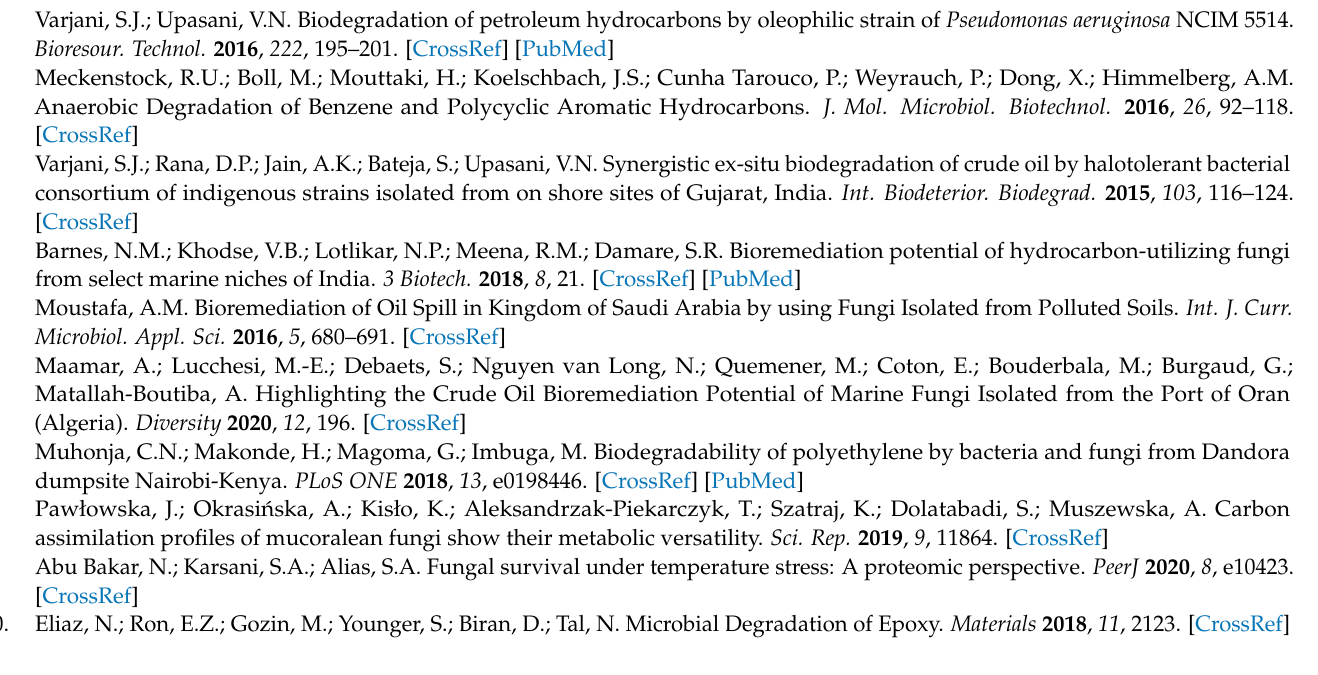
D. spicifera , Figure S2: Emulsification test of different hydrocarbons. The emulsification activity